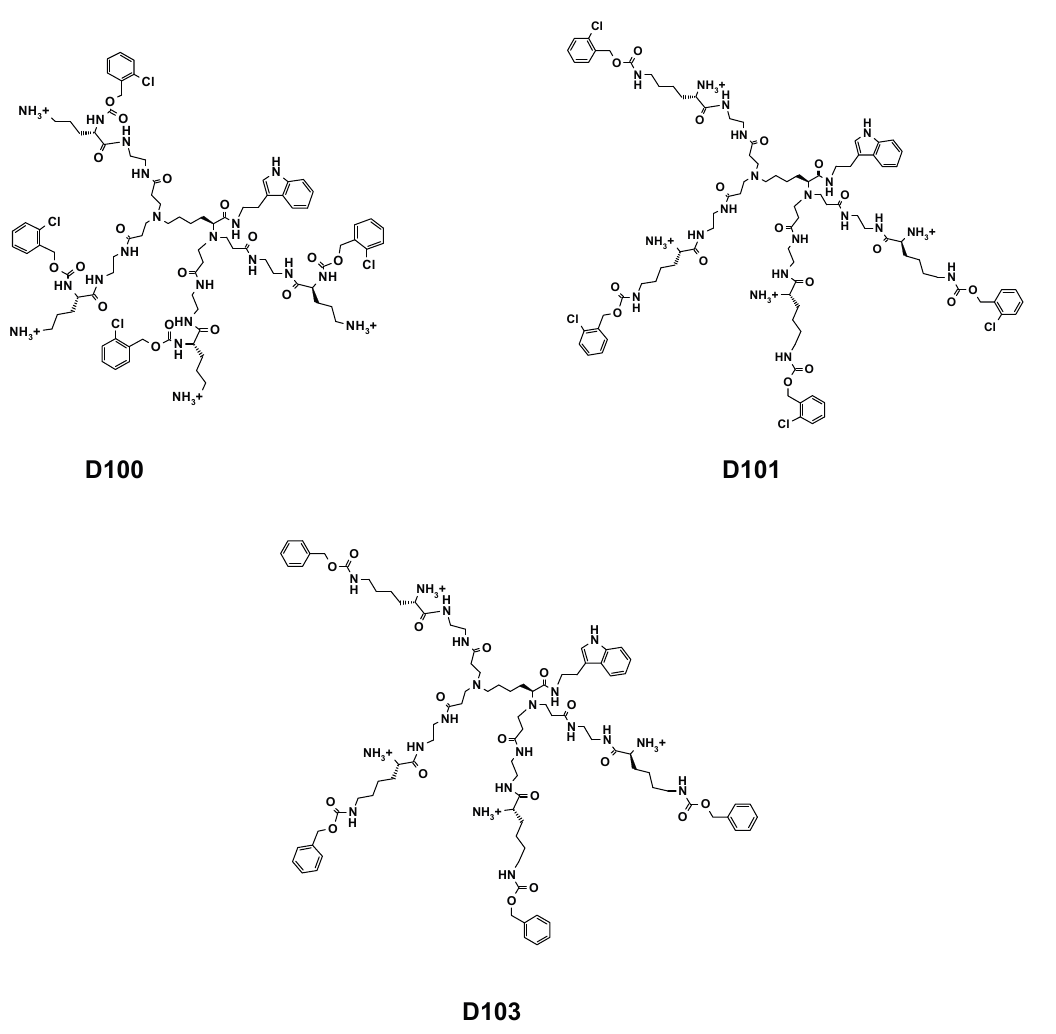
Figure 1. Chemical structures of the studied dendrimers D100, D101 and D103. Dendrimer D101 and D103 are structurally similar in terms of the distribution of hydrophobic groups and the charges. However, dendrimer D103 lacks chlorine atoms in the hydrophobic surface residues and this chemical difference makes dendrimer D103 ten times less active against both Gram-positive and Gram-negative strains as compared to D101. Table 1 also shows the hemolytic properties of the dendrimers (HEM), expressed as the dendrimer concentration that induces cell lysis of 100% erythrocytes in relation to a standard. Interestingly, compound D100 is two times less hemolytic than D101, although it presents the same potency against Gram-positive bacteria as D101. The less anti-microbial active compound D103 is also much less harmful against red blood